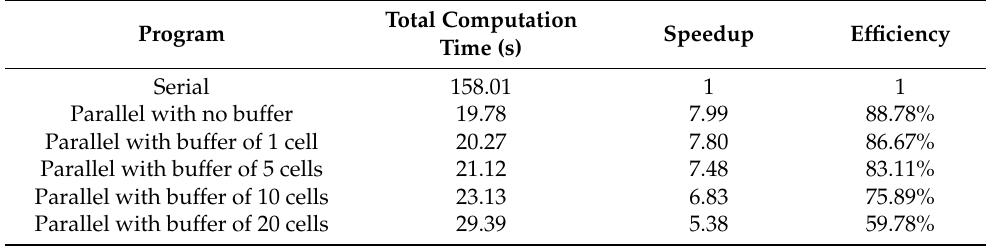
Table 3. The speedup and